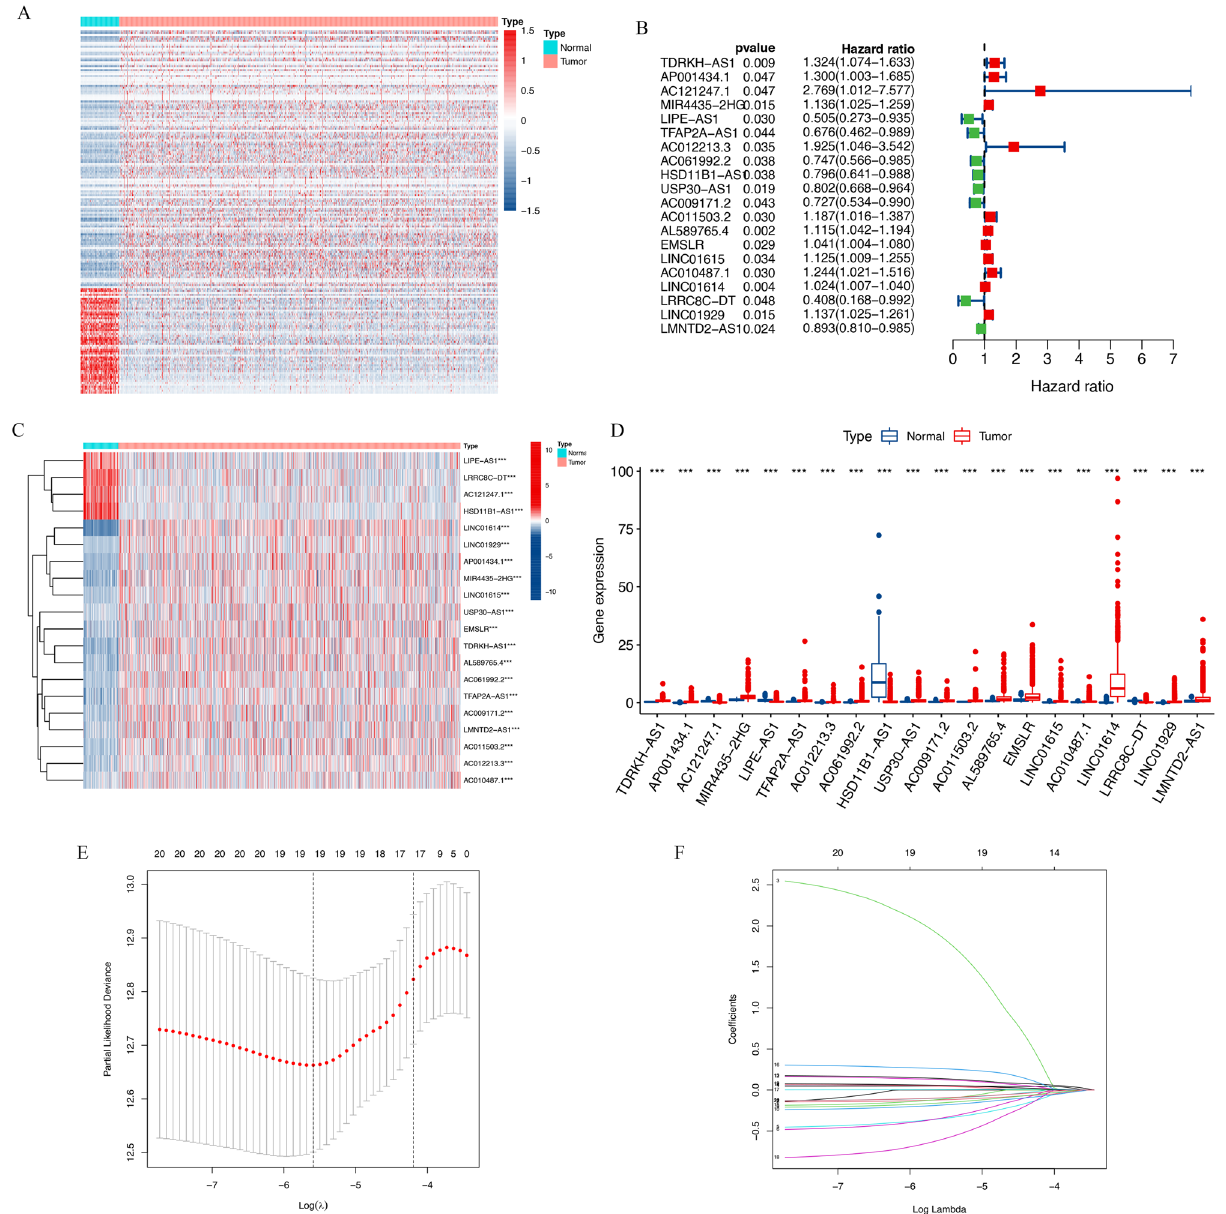
Figure 2. Identification of the prognostic differentially expressed mitochondrial function-related lncRNAs in BRCA patients. ( A ) Heatmap of the 383 differentially expressed mitochondrial function-related lncRNAs. ( B ) Forest plots showing a total of 20 differentially expressed mitochondrial function-related lncRNAs associated with OS in univariate Cox regression analysis. ( C ) Heatmap of the 20 lncRNAs from the results of univariate Cox regression analysis. ( D ) Boxplot of different expressions of the 20 lncRNAs from the results of the univariate Cox regression analysis. ( E , F ) The mitochondrial function-related lncRNA signature was then constructed by lasso regression